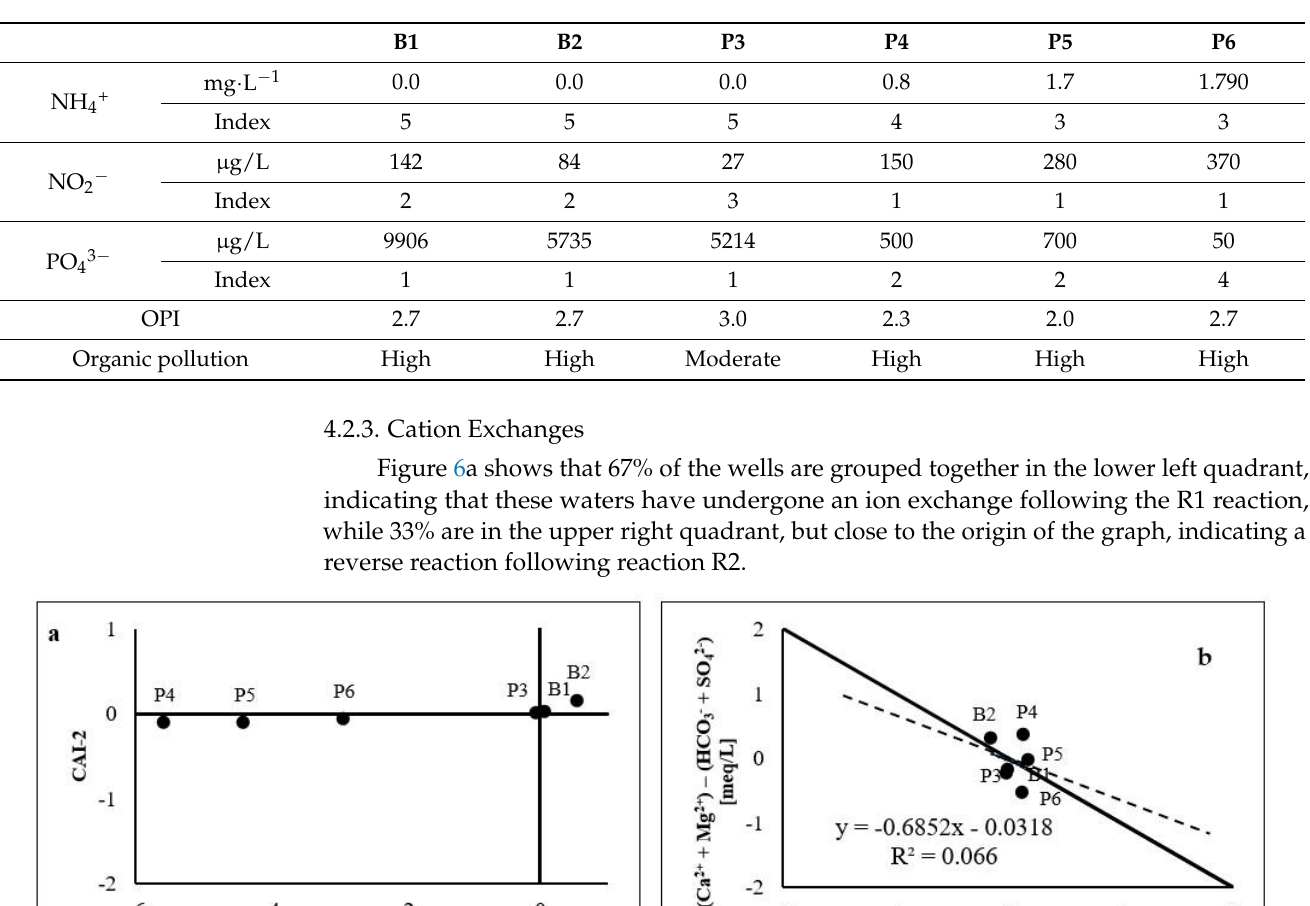
Table 4. Index of the organic pollution of groundwater.